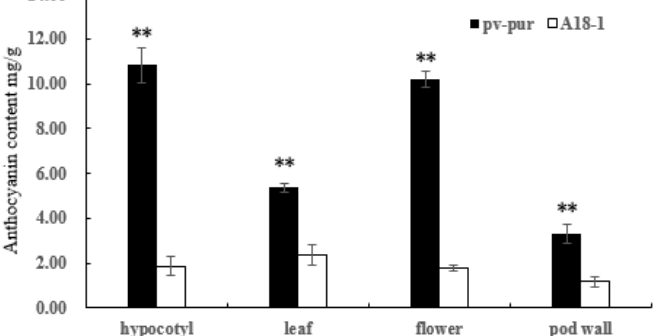
Figure 2. Anthocyanin content in various tissues of mutant ‘ pv-pur ’ and wild type ‘A18-1’. Note: ** represents significant differences at p ≤ 0.01 based on ANOVA (Tukey test).